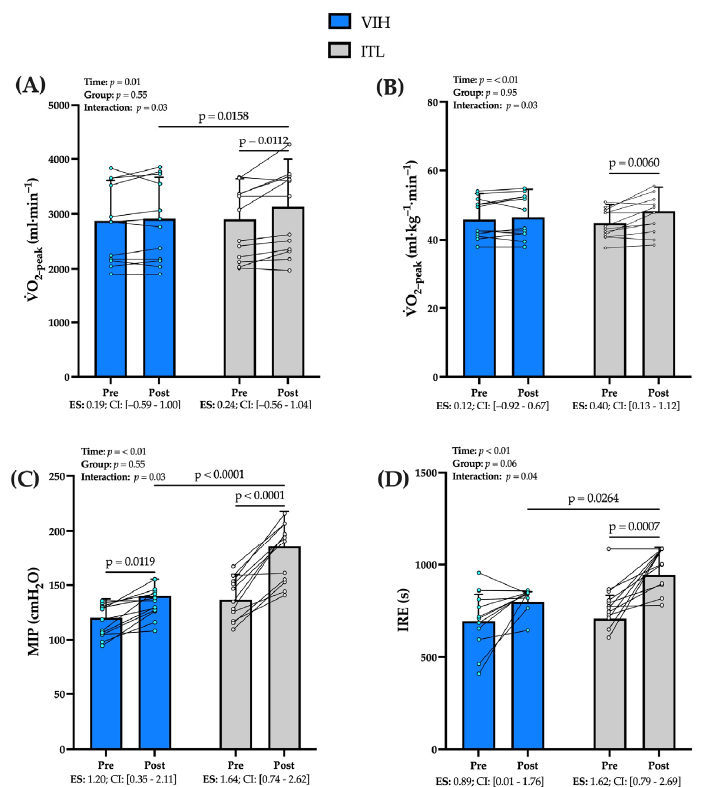
Figure 3. Comparison on changes in ( A ) absolute oxygen uptake ( VO 2-peak , ml·min − 1 ), ( B ) relative oxygen uptake ( VO 2-peak , ml·kg − 1 ·min − 1 ), ( C ) m.vastus lateralis ( Δ SmO 2- m. vastus lateralis , %). Data are shown in mean ± SD. The factors (time and group) and their interaction are shown (group X time). Effect size (ES) are shown with confidence interval (CI) at 95%.